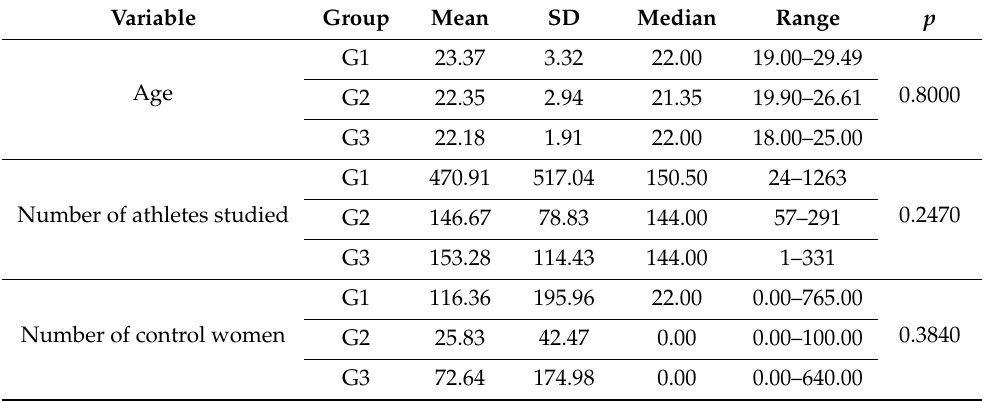
Table 1. Age, number of athletes studied and control women in the studies performed in G1, G2 and G3.